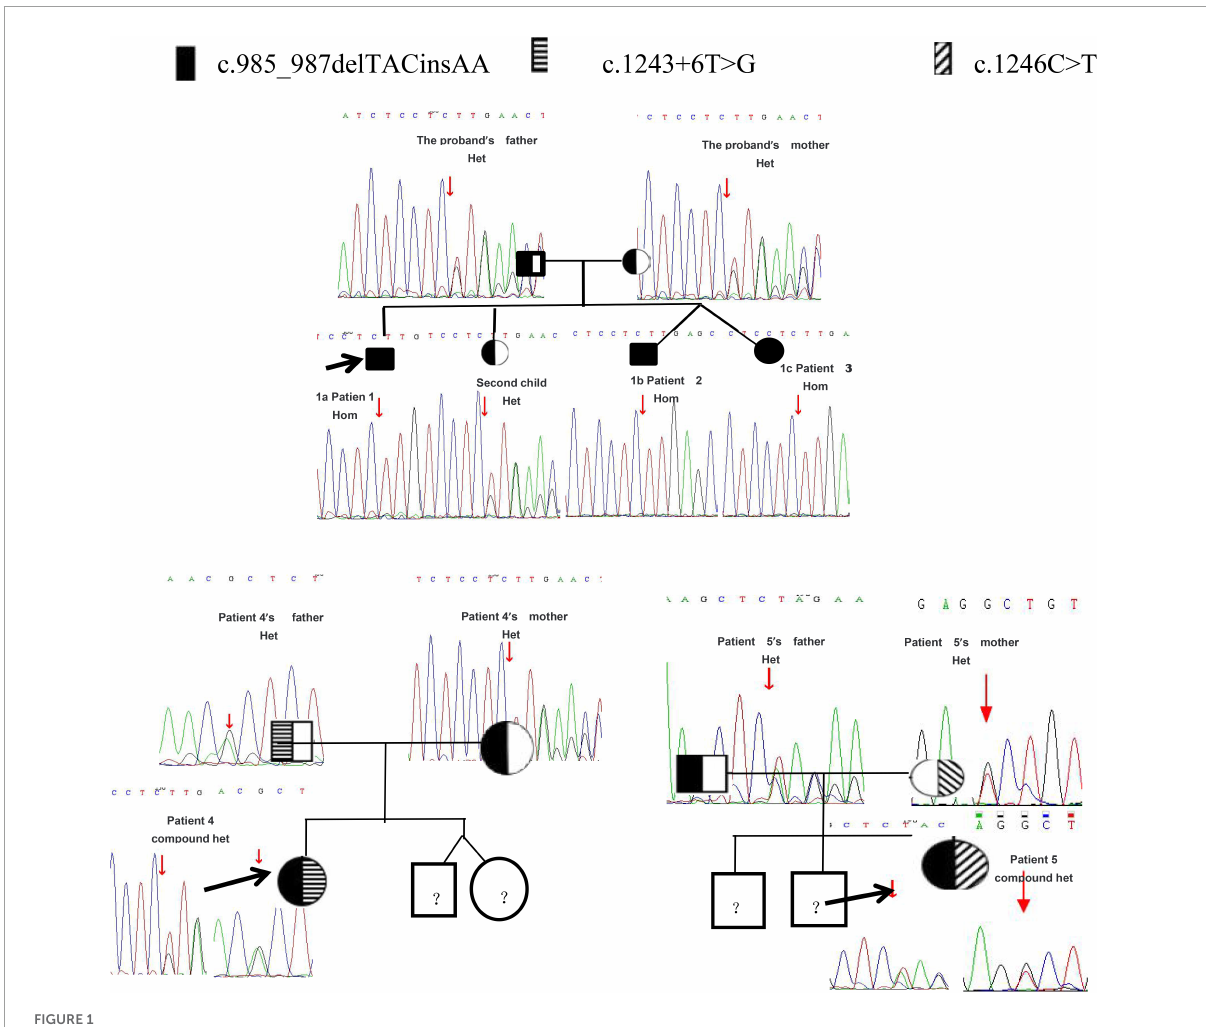
FIGURE1 The pedigree and gene sequencing results of five patients.